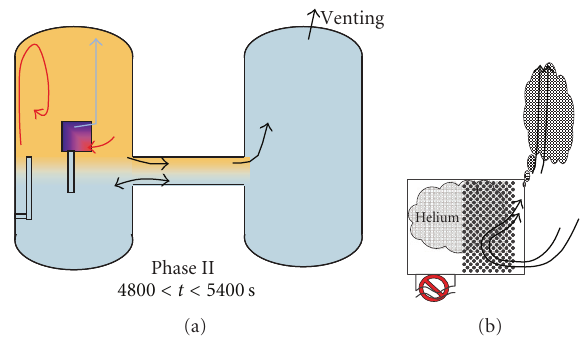
Figure 15: Suggested flow pattern for 4800 < t < 5400 s.